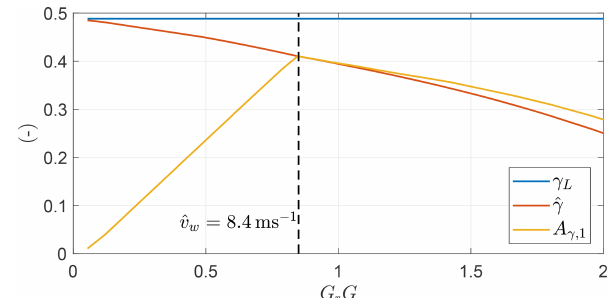
Figure 36. Norm of the optimal AWES velocity v as function of the angular position.